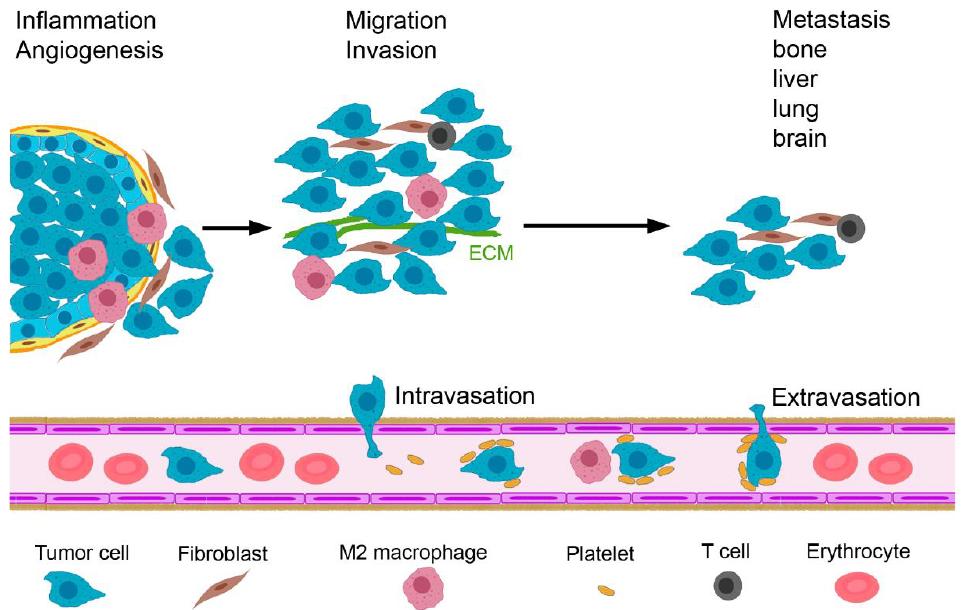
Figure 1. Important steps in the metastasis of invasive breast cancer. Tumor initiation is favored by inflammation, angiogenesis and hypoxia. Upon tumor progression, tumor cells migrate, invade the stroma and intravasate into the blood vessels. Tumor cells in the circulation are protected by plate- lets and activate monocytes to M2 macrophages. Extravasation takes place supported by macro- phages and neutrophilic granulocytes and guided by a cytokine gradient, and metastasis in bone, liver, lung and brain occur. Abbreviation: ECM, extracellular